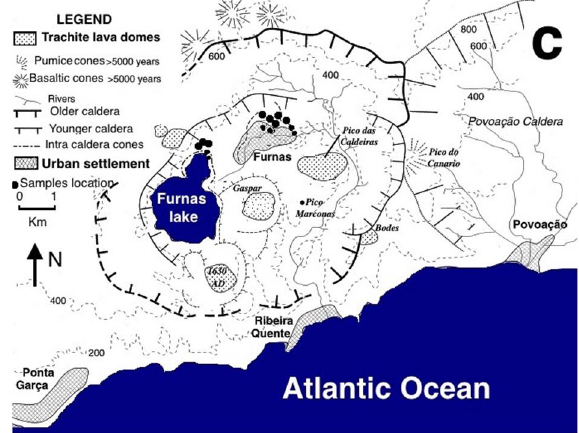
Figure 1. ( a ) Major tectonic features of Azores triple junction [36]. ( b ) The volcanological map of São Miguel [34,37], F-faults; ( c ) The simplified geological map of the craterial area of Furnas volcano [38,39].